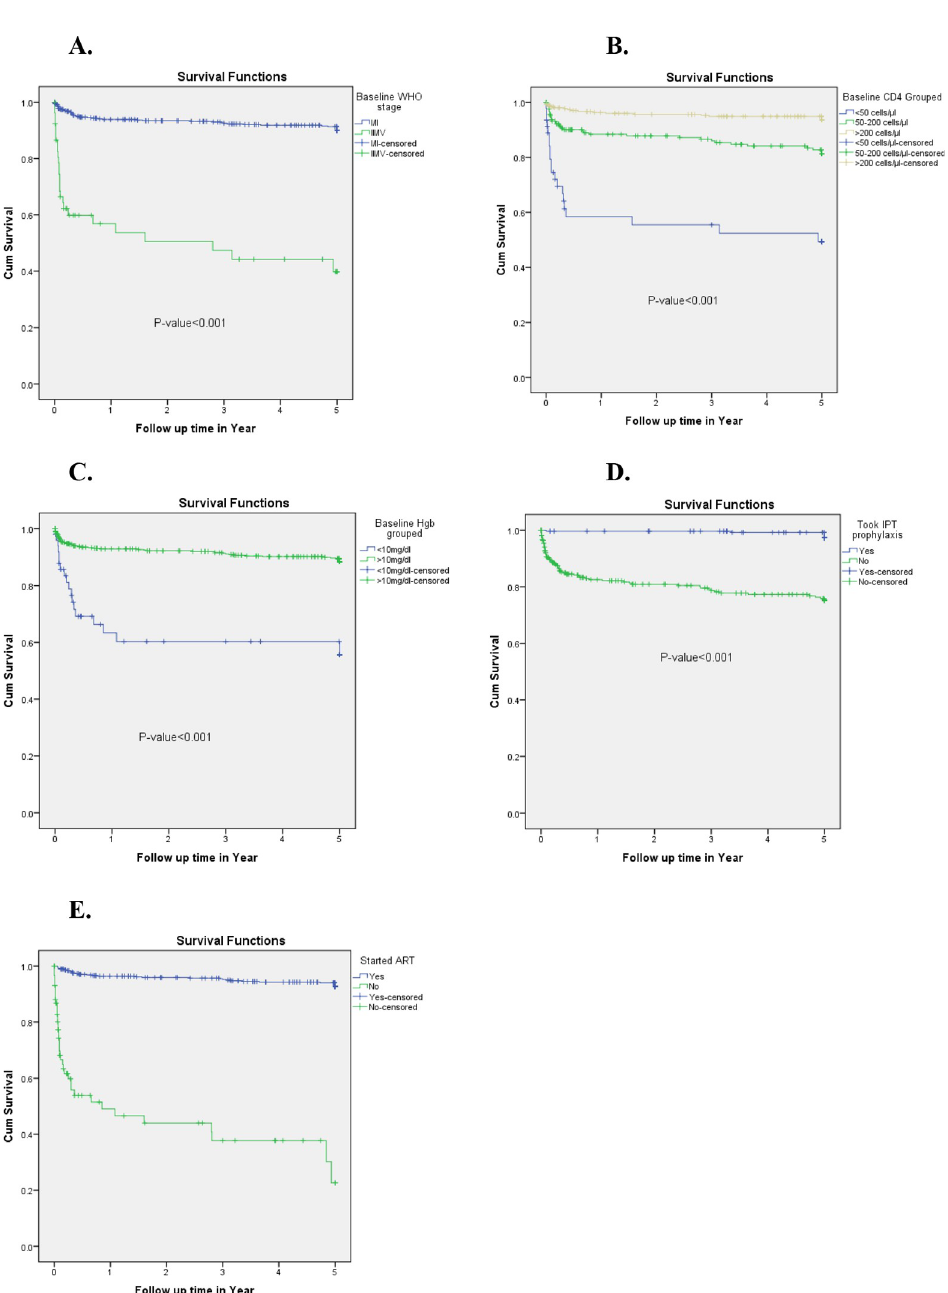
Fig 4. Kaplan-Meier survival curves of patients with extrapulmonary tuberculosis based on baseline WHO stage (A), baseline CD4 (B) count, baseline anemia (C), IPT intake(D) and enrollment on HAART (E) among HIV positive patients in Addis Ababa, Ethiopia, from 01 January 2013 up to 31 December 2018 (n = 566).